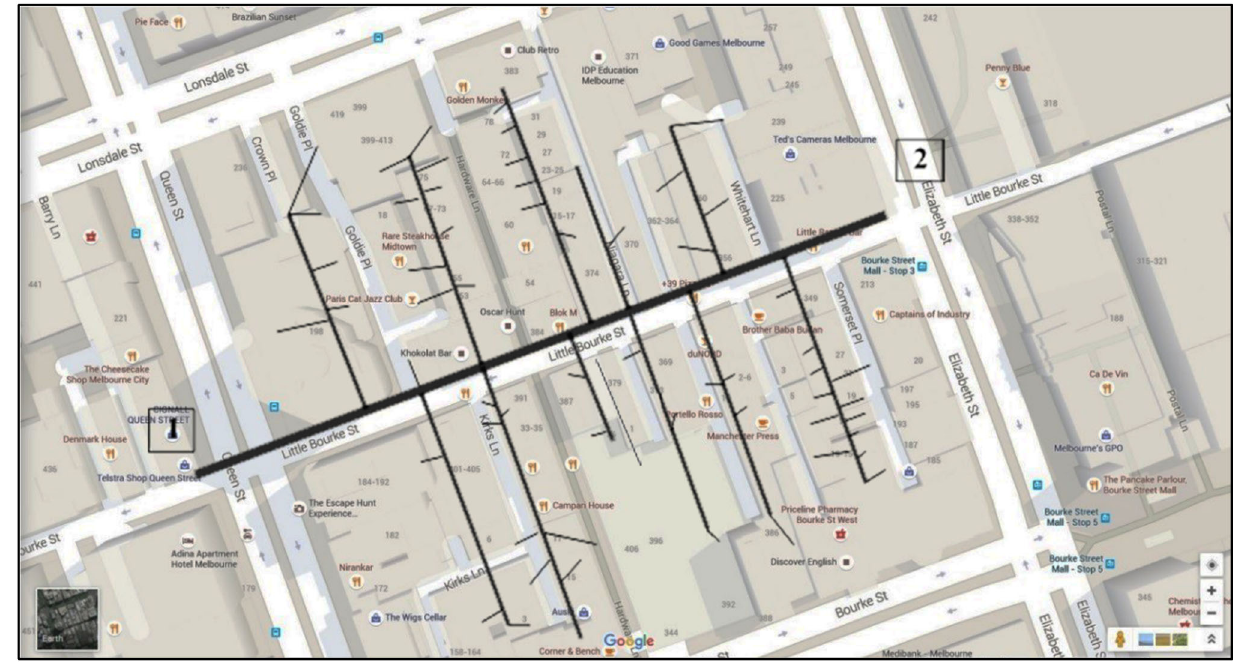
Fig. 5 Places of interest identified with links or nodes ( map : part of Melbourne’s